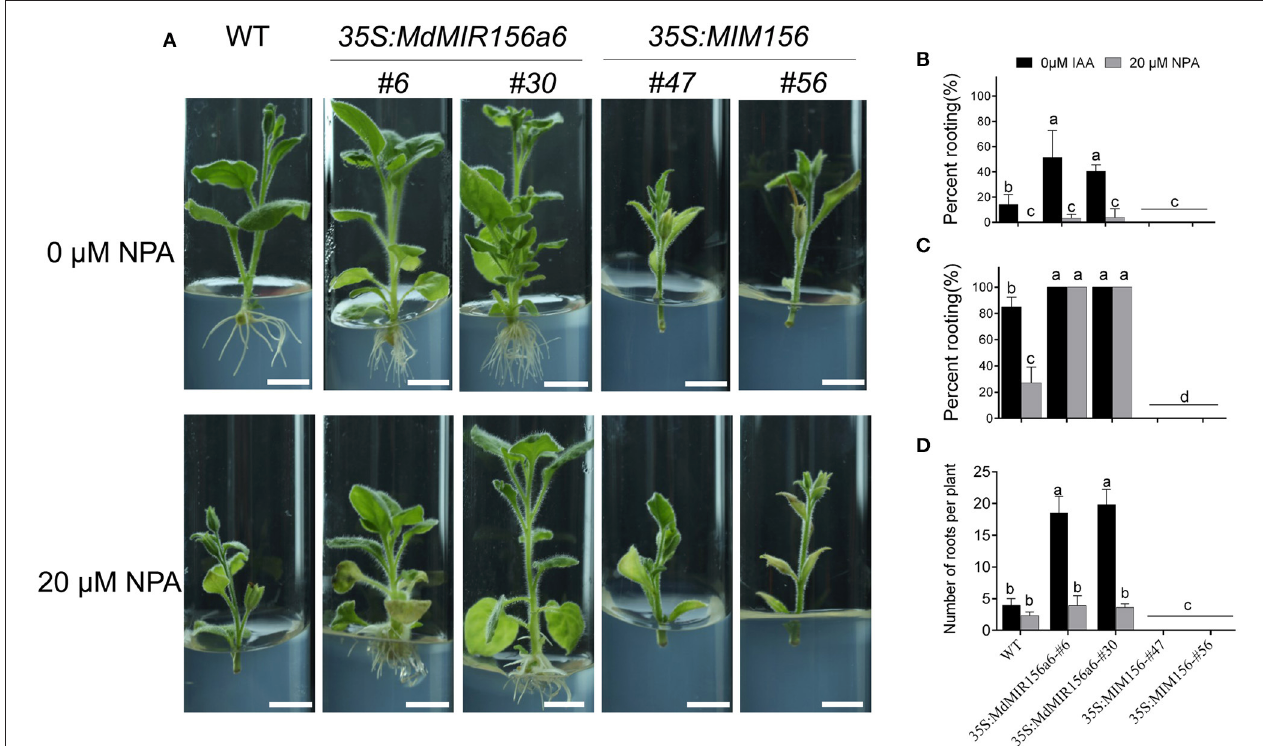
FIGURE 6 | Effects of NPA on adventitious root formation in 35S:MdMIR156a6 and 35S:MIM156 tobacco plants. (A) Phenotypes of 13-day-old plants (WT, 35S:MdMIR156a6, and 35S:MIM156 ) grown on MS medium with 20 µ M NPA. Scale bars = 15 mm. (B,C) Percent rooting of tobacco stem cuttings grown on MS medium with 20 µ M NPA treatment for 7 and 14 d, respectively. (D) Adventitious root numbers per cutting. Bars show SD with three biological replicates; n = 10 cuttings in each replicate. The statistical analysis was performed by Duncan’s multiple range test at level p ≤ 0.05. The different lowercase letter indicate significant